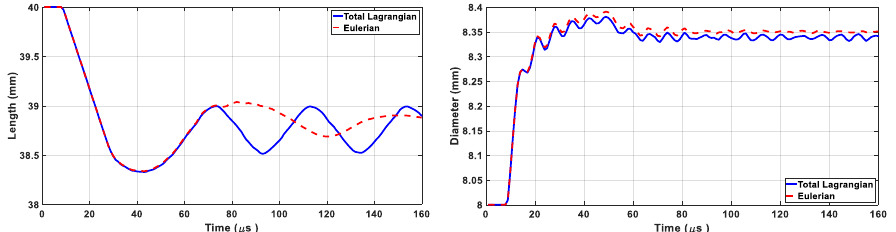
Fig. 3. Numerical results showing plastic deformation comparison between re-normalised Eulerian SPH (red) and TLSPH (blue)